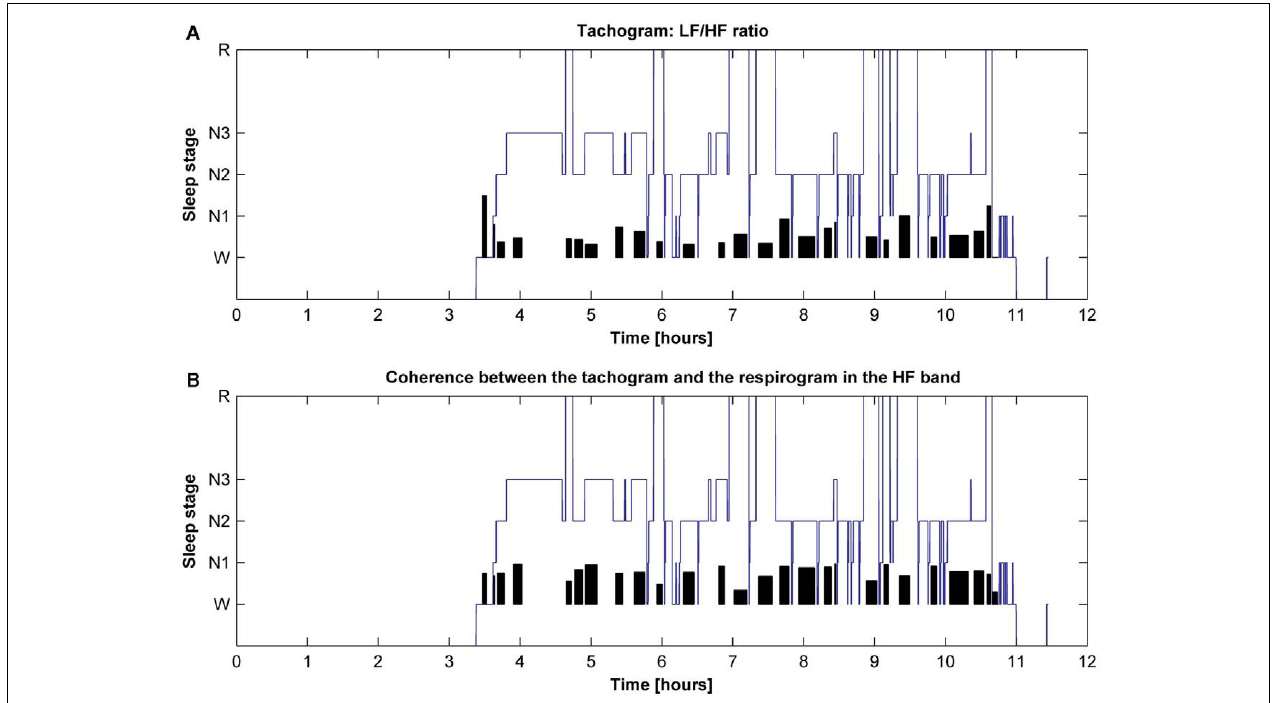
FIGURE 6 | Hypnogram of one subject with indication in black of (A) the trend of the tachogram LF/HF ratio for the whole night and of (B) the trend of the coherence between the tachogram and the respirogram in the HF band.